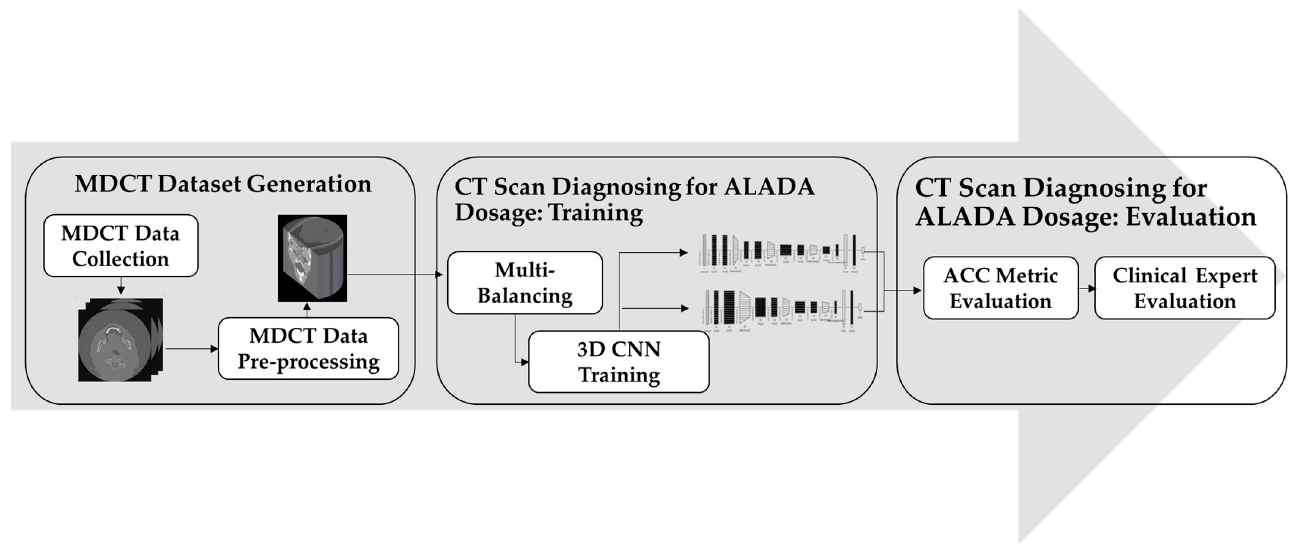
Figure 1. Proposed CT scan identification of the ALADA dosage